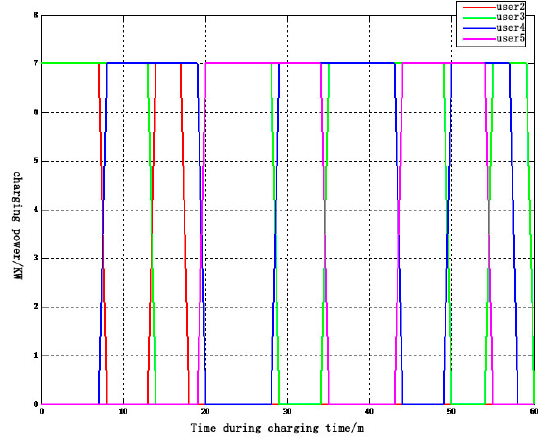
Figure 5. Charging time allocation result from 20:00 to 21:00 hours.